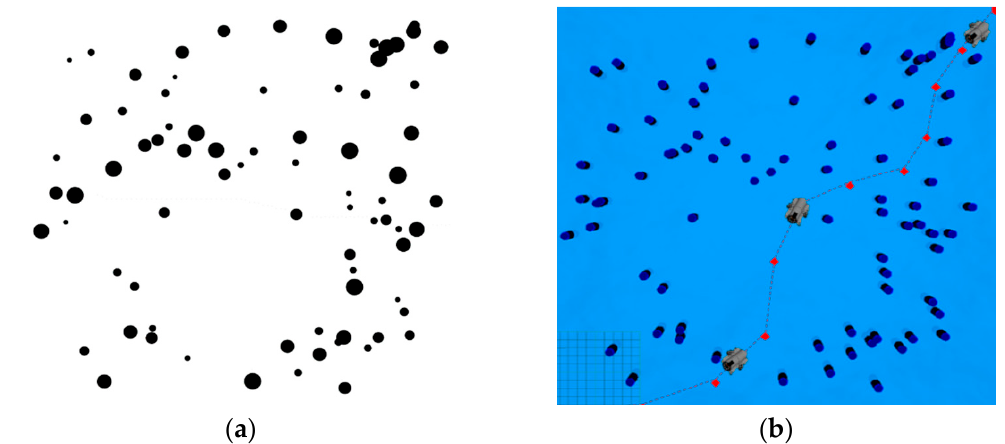
Figure 9. The simulation results of path-planning task. ( a ) Convert Gazebo world file to PGM map. ( b ) The trajectory of the UUV in the simulation platform.